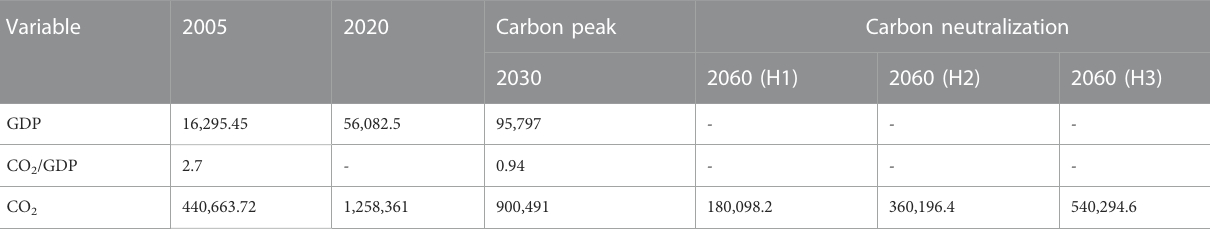
TABLE 1 Three carbon neutralization scenarios in 2060.